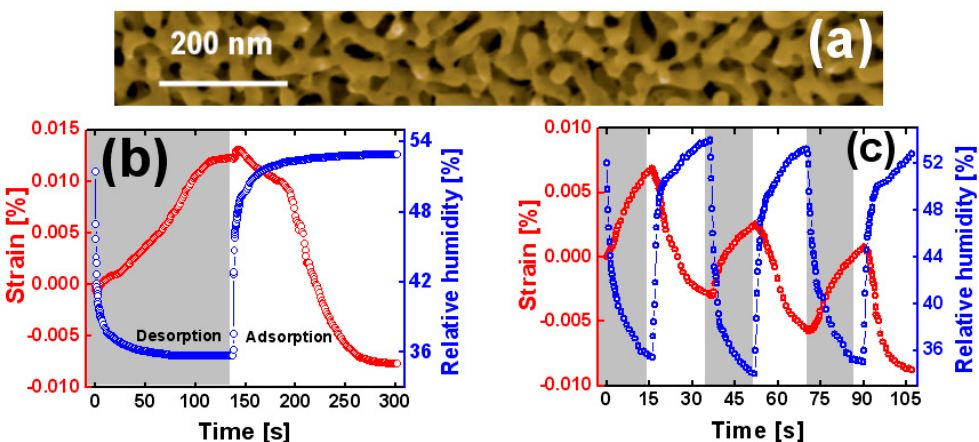
Figure 4. Ligament size-dependence of the charge-induced strain in nanoporous metals (Au). The strain amplitude that was recorded on five specimens with different ligament sizes decreased with increasing ligament size. This shows that ligament growth during electrochemical actuation is undesirable [67,68].